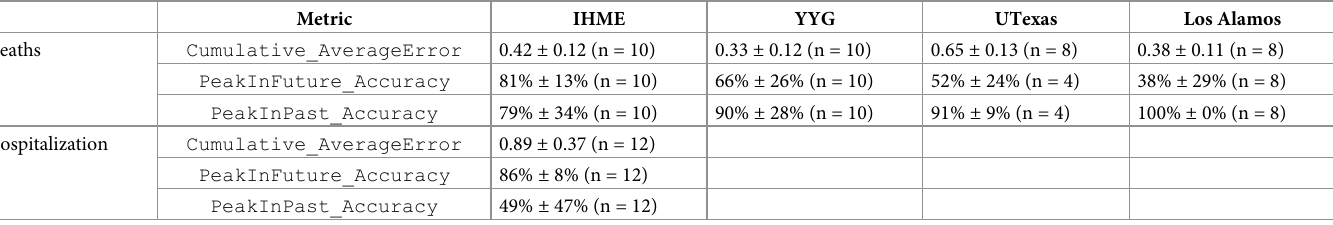
Table 3. Values of all other validation metrics. Mean ± SD are presented, where the mean is average of metric across the peak events. n = number of peak events. Metric IHME YYG UTexas Los Alamos Deaths Cumulative_AverageError 0.42 ± 0.12 (n = 10) 0.33 ± 0.12 (n = 10) 0.65 ± 0.13 (n = 8) 0.38 ± 0.11 (n =